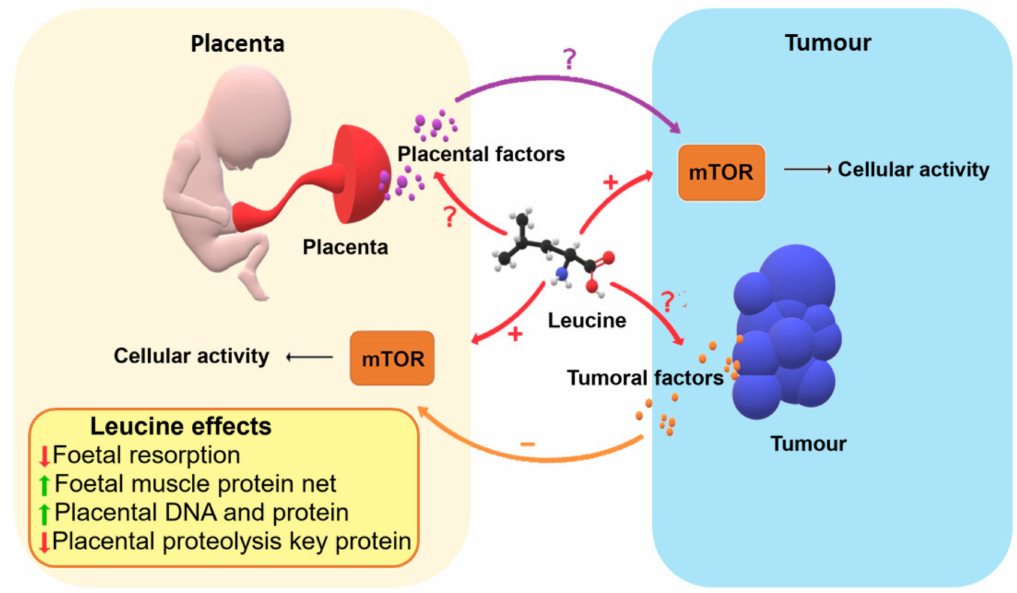
Figure 1. Mechanisms of how leucine nutritional supplementation to the mother could improve some points in minimising cancer damage factors. Foetal resorption could be decreased with a positive foetal muscle protein net, and the placenta may also benefit with a decrease in proteolysis, maintaining the protein synthesis/proteolysis ratio, which leads to physiological DNA and protein